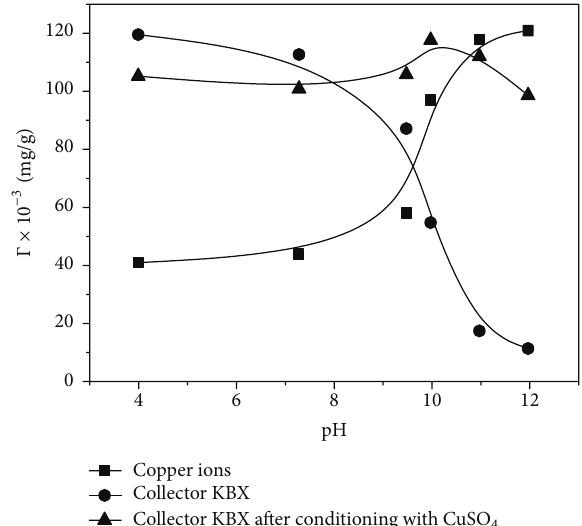
Figure 2: Effect of dosage of CuSO 4 on pyrite flotation (conditions: KBX 10mg/L).